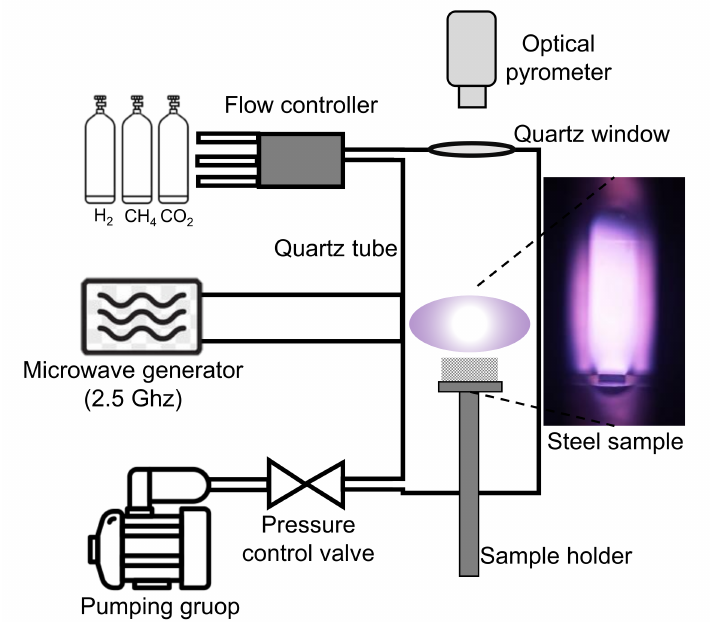
Figure 2. Schematic view of the experimental set-up used for plasma treatments.